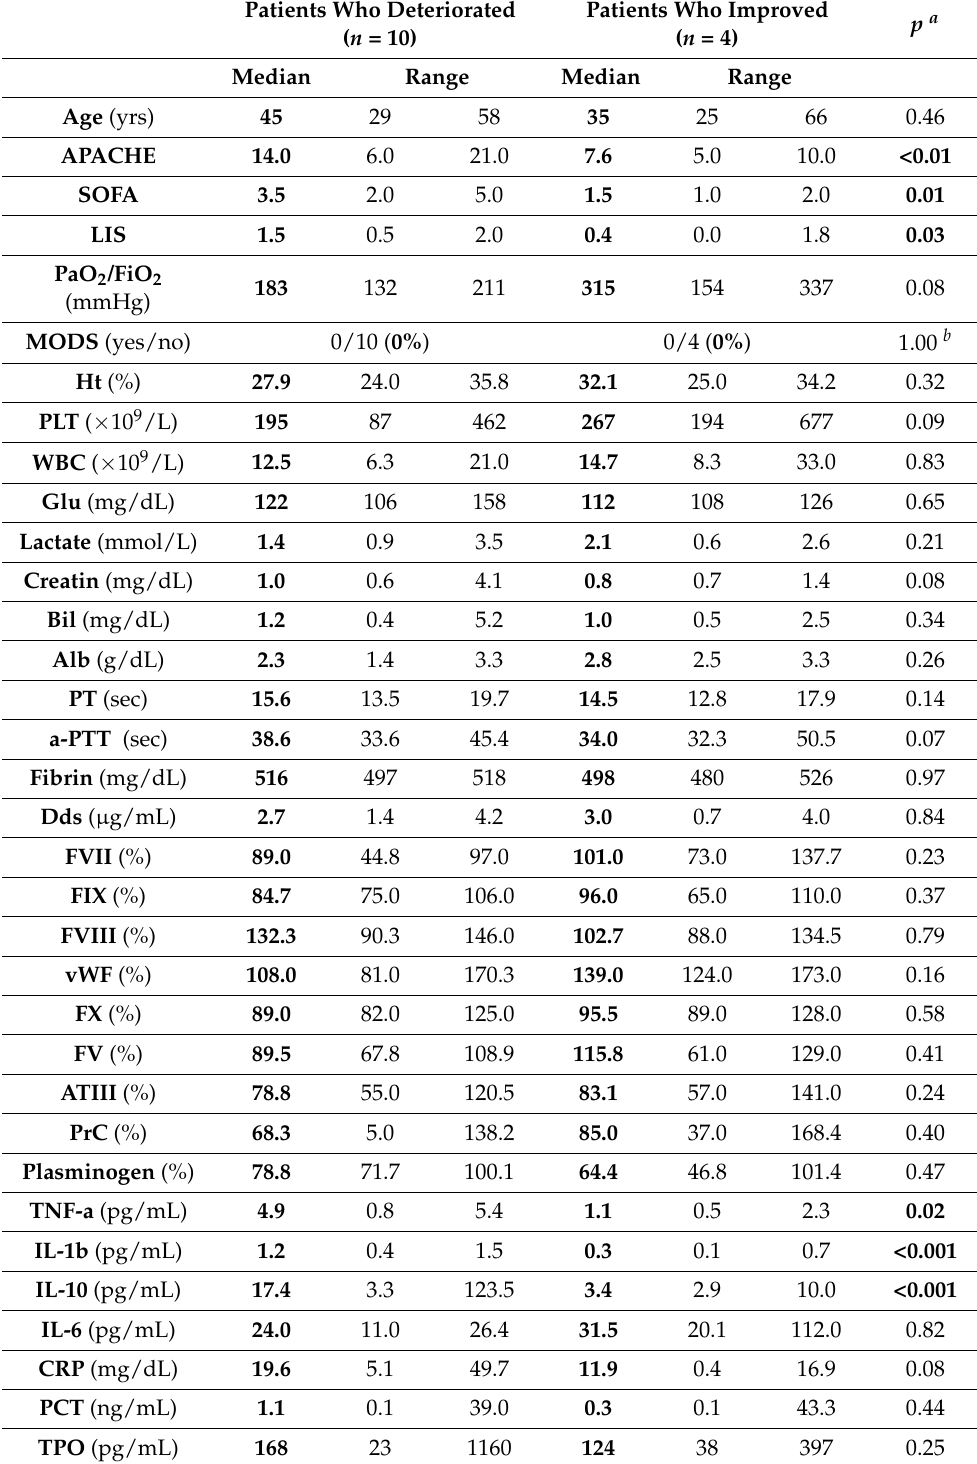
Table 5. Diagnosis of Sepsis on ICU